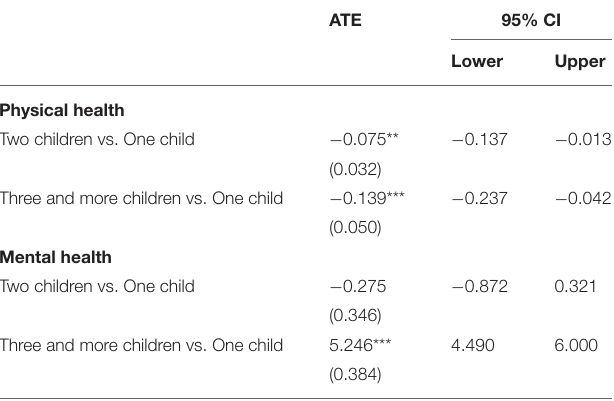
TABLE 4 | Results of inverse probability of treatment weighting regression adjustment (IPTW–RA).